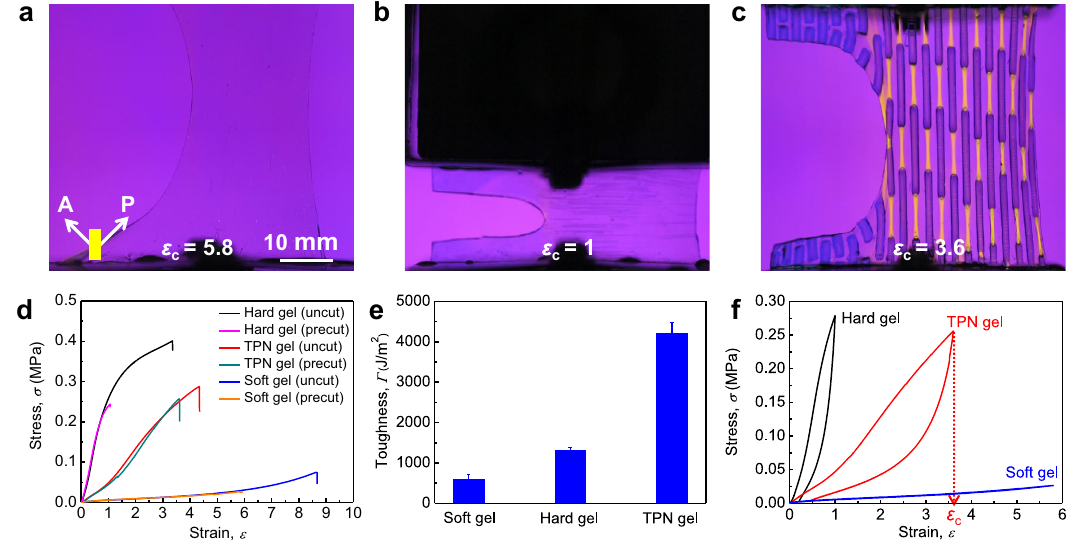
Fig. 3 Fracture of TPNs. a – c In situ polarizing optical observation of a soft gel, b hard gel, and c TPN gel. In each case, the image is taken when the gel with a precut crack is stretched to the critical strain ε c for rupture. d Stress – strain curves of gels with and without precut crack. e Toughness of the three gels. At least three samples were tested for the calculation of average value and standard deviation. f Load – unload stress – strain curves of the three uncut gels stretched to the critical strains for their corresponding precut